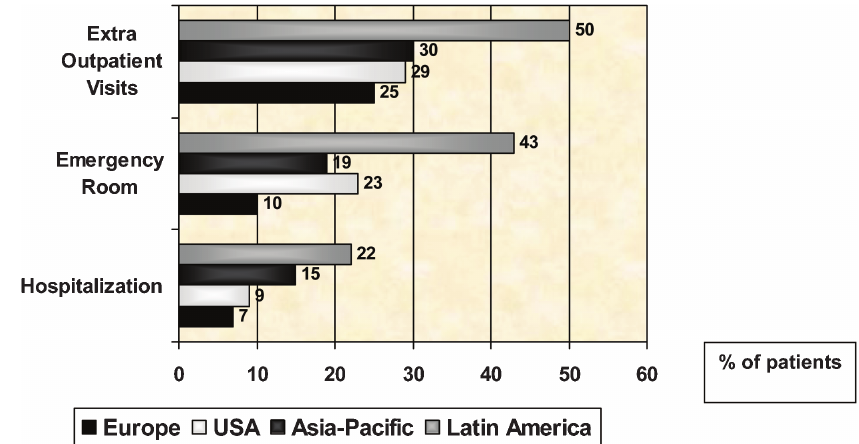
Figure 8 - Rate of severe exacerbations of asthma in the last